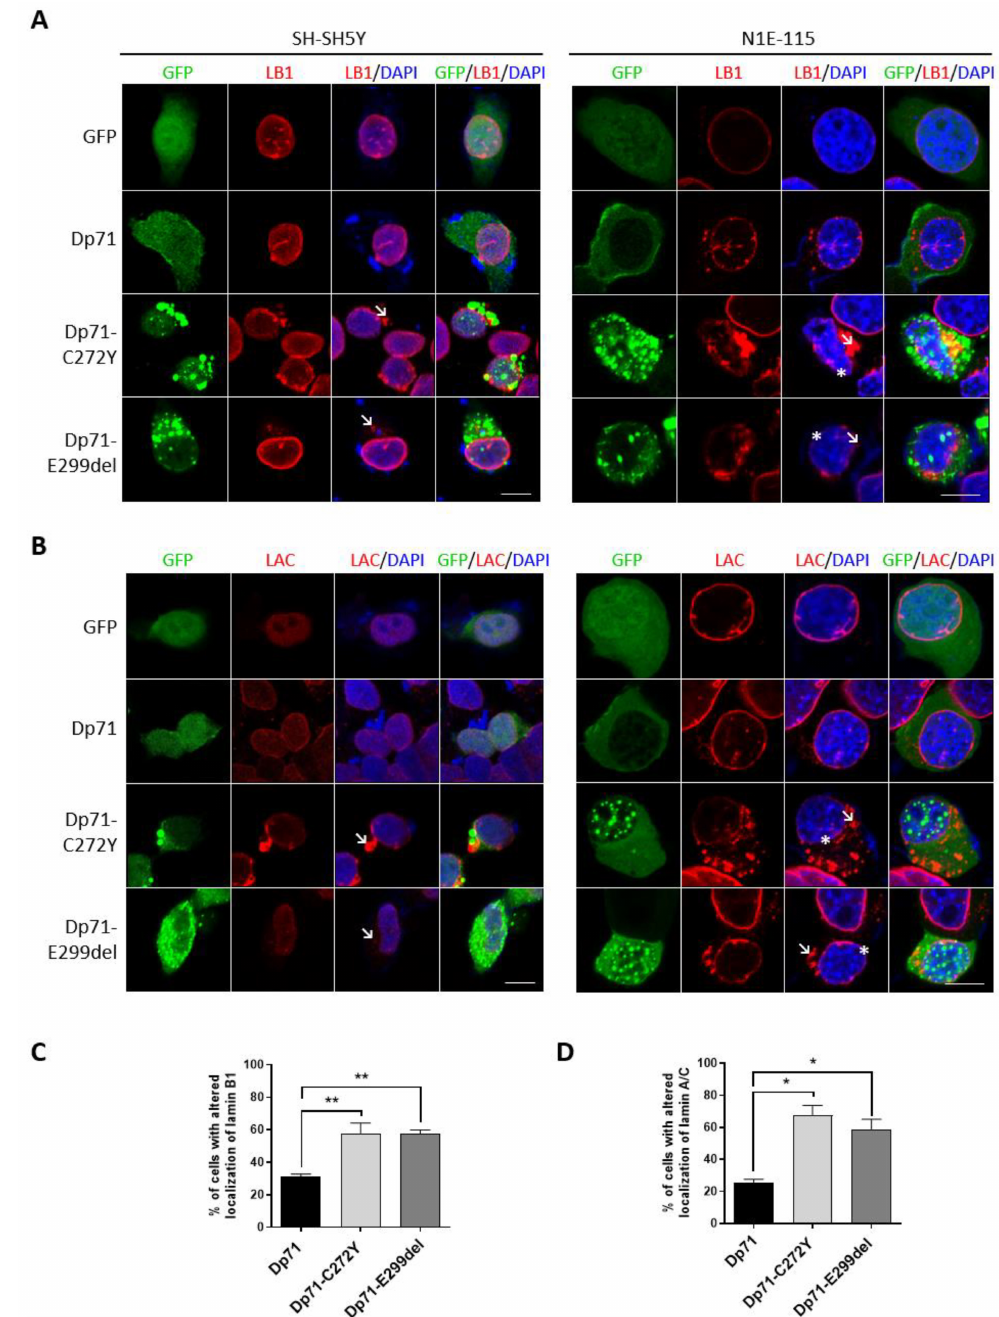
Figure 5. Neuronal cells expressing Dp71-C272Y or Dp71-E299del exhibit the altered localization of nuclear lamins. SH-SY5Y and N1E-115 cells transiently expressing GFP, GFP-Dp71, Dp71-C272Y or Dp71-E299del were immunostained for lamin B1 (LB1) ( A ) or lamin A/C (LAC) ( B ) and counter- stained with DAPI to visualize nuclei, prior to being imaged by CLSM. Typical optical Z-sections are shown (scale bar = 10 µ m). Cytoplasmic aggregates of nuclear lamins are denoted by arrows, and their faint discontinuous labeling is denoted by asterisks. The percentage of SH-SY5Y-transfected cells showing the aberrant distribution of lamin B1 ( C ) or lamin A/C ( D ) is shown. Results represent the mean +/ − SEM of three independent experiments (n = 100 cell per experimental condition), with significant differences calculated using one-way ANOVA and Dunnett’s multiple comparison test (*, p < 0.05; **, p <